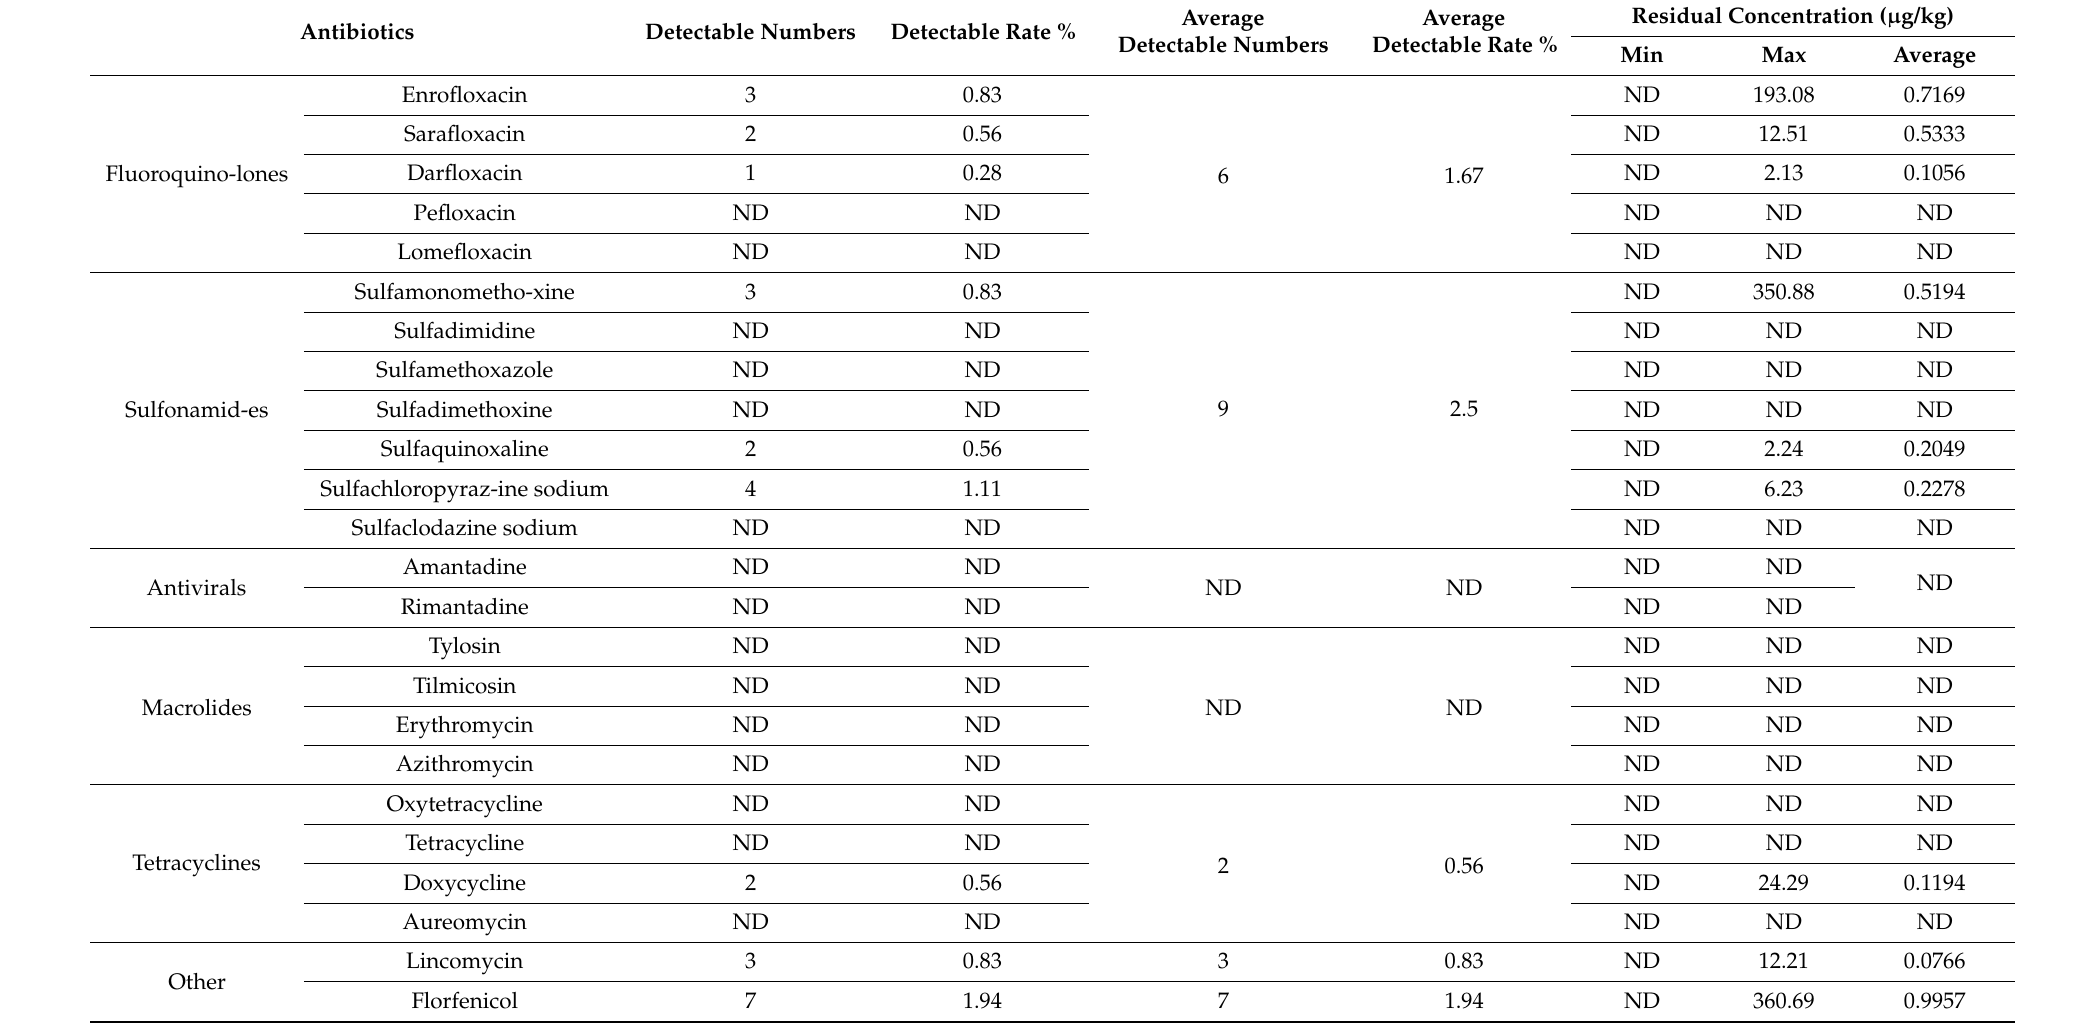
Table 5. Residues of antibiotics in eggs in